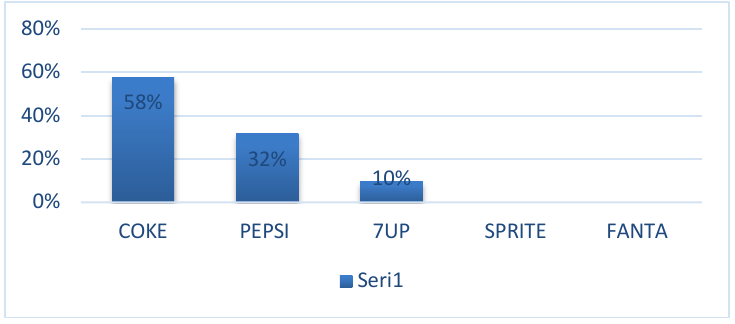
Figure 5: Answers on Which cola drink do you prefer most?